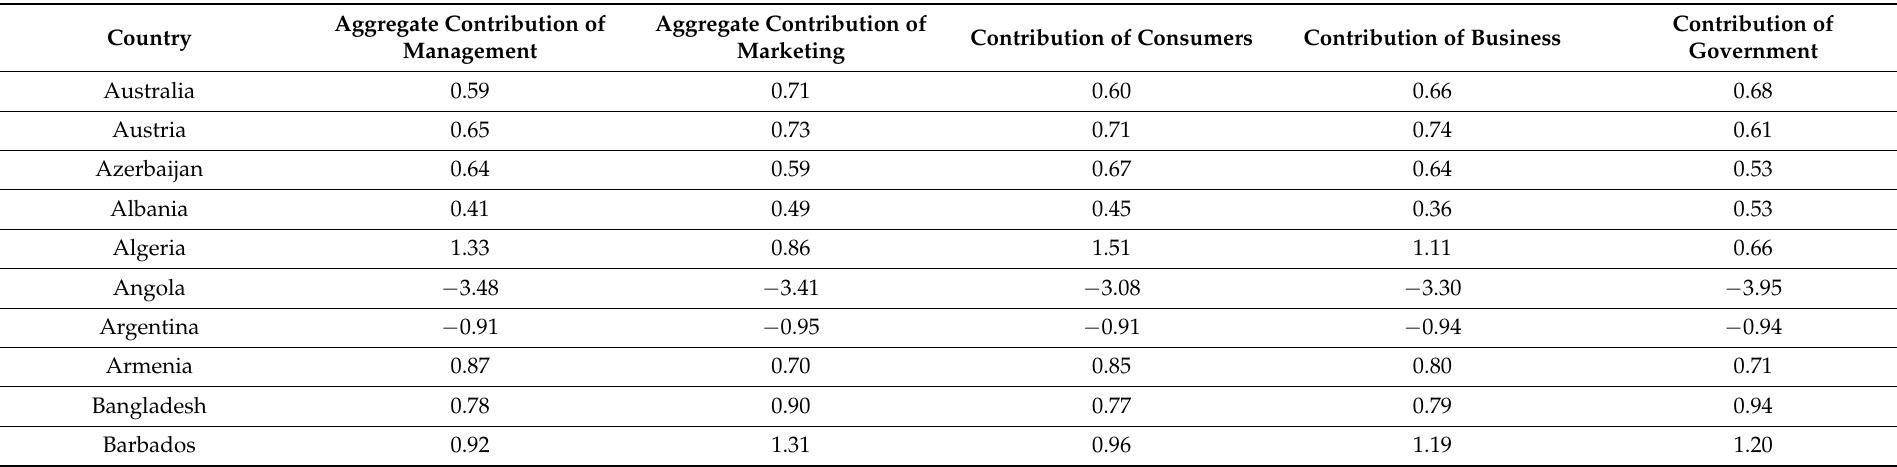
Table A7. Contribution of a set of management and marketing factors to the pandemic risk management in the third trimester of 2020.